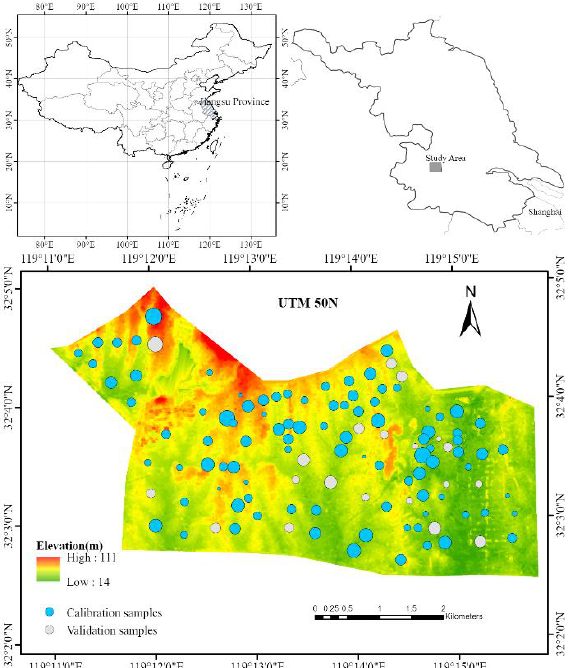
Figure 1. Distribution of study area and sampling points. Note: the sample point size represents the amount of SOC content (4.29~19.79 g/kg).